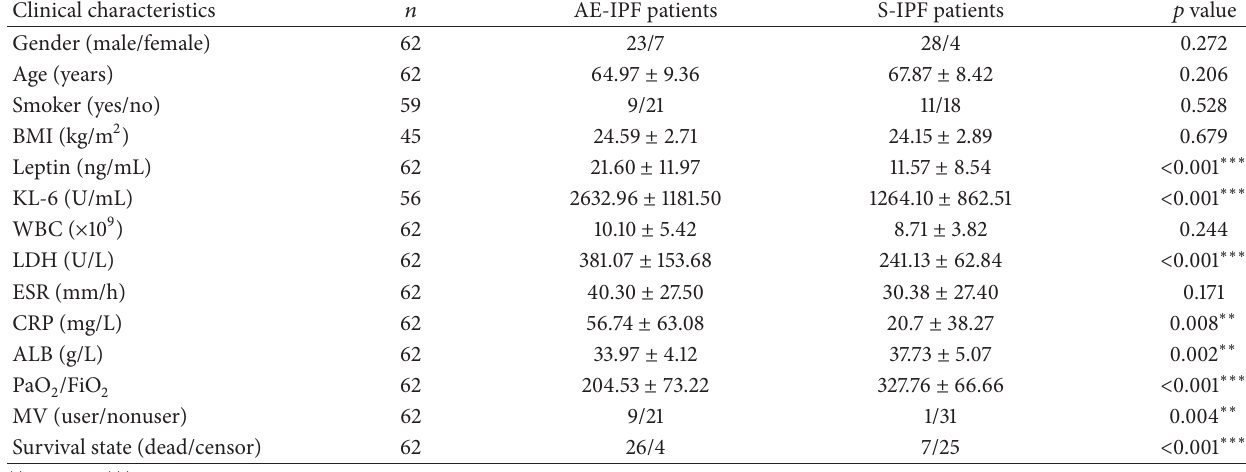
Table 1: Baseline clinical characteristics of patients with AE-IPF and S-IPF.